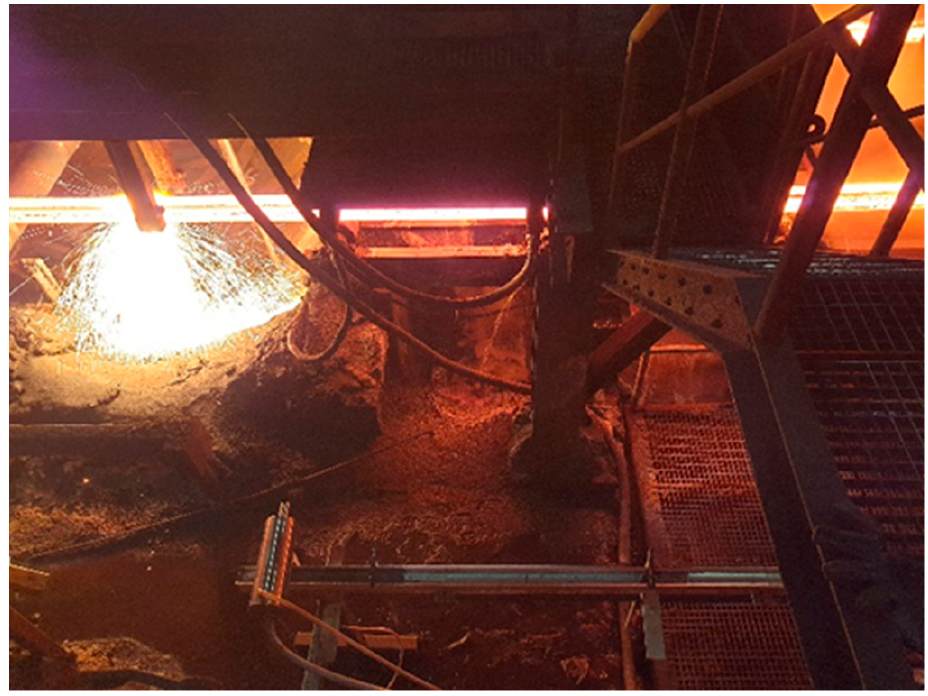
Figure 1. Laser vibrometer mounted on rail to measure strand vibrations along ESF billet caster.